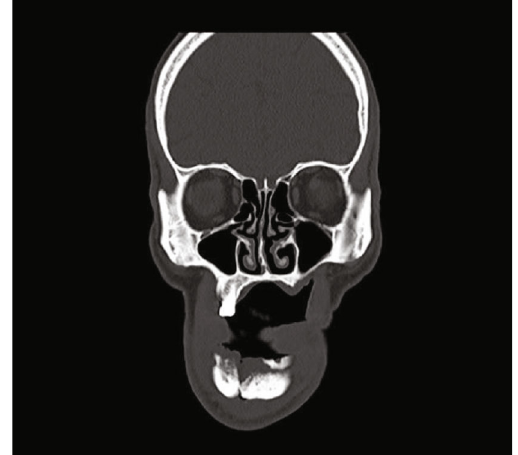
Figure 14: Postop photograph after second